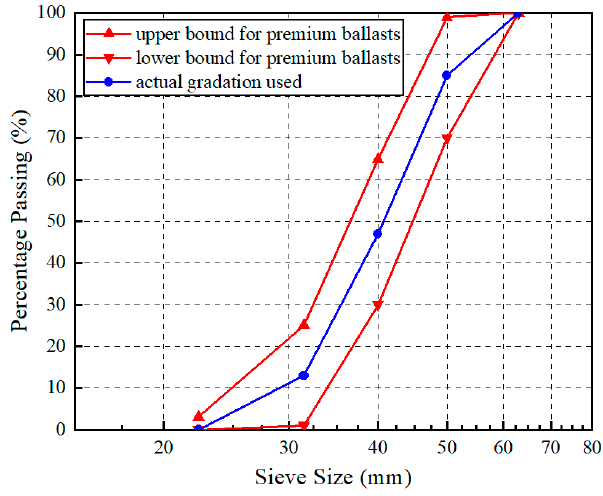
Figure 6. The particle-size-distribution curves of ballast materials designed for impact-load tests. The specific impact-load-test matrix for multiple-size ballasts is shown in Table 2. Table 2. The impact-load-test matrix for multiple-size ballasts.